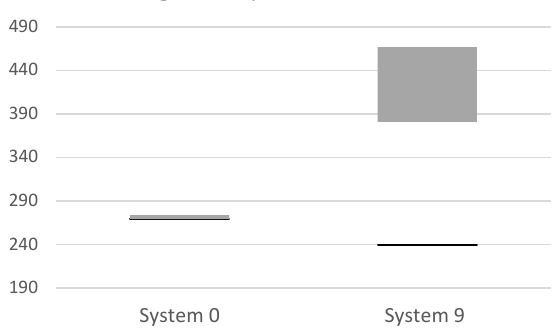
Figure 10. Optimal cost results for Systems 0 and